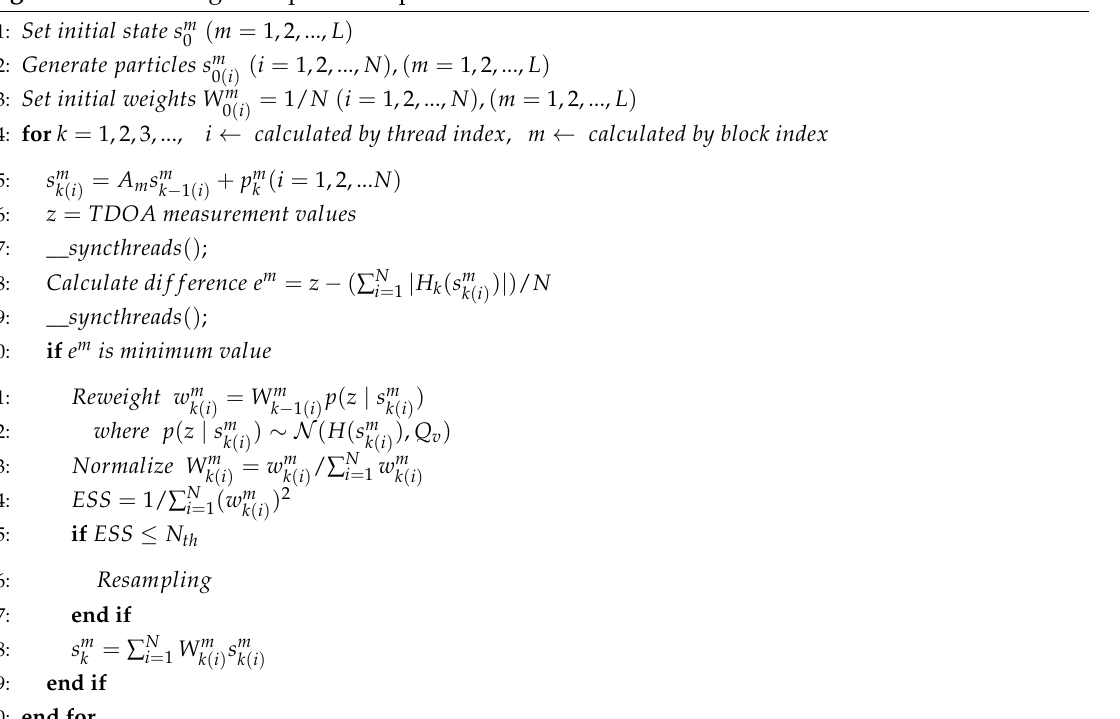
Algorithm 3 PF using multiple state-space models in